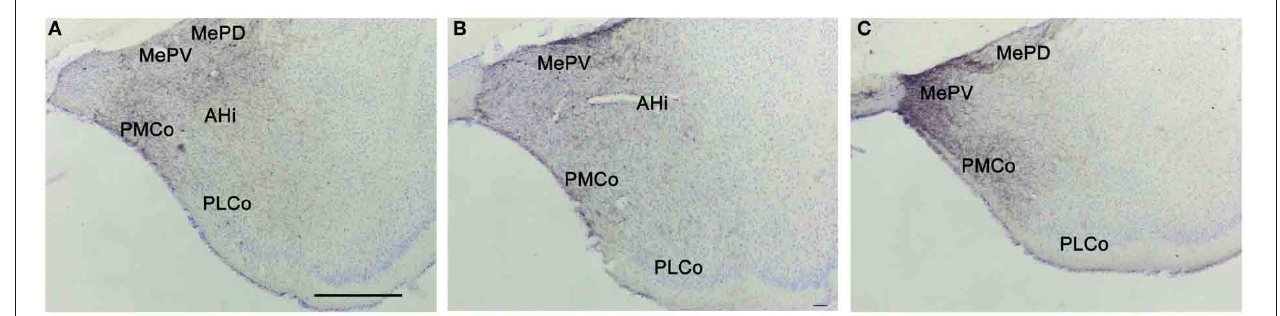
FIGURE 3 | Anterogradelabeling in theamygdala after tracerinjectionsin the differentsubdivisionsof themedial amygdaloidnucleus. Photomicrographs oftransverse sections through theamygdalaofCD1animals